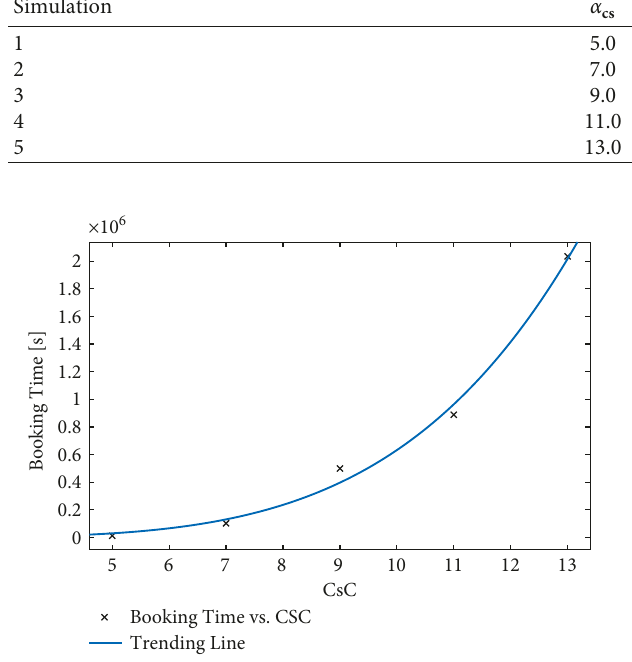
Figure 1: Booking Time vs CsC